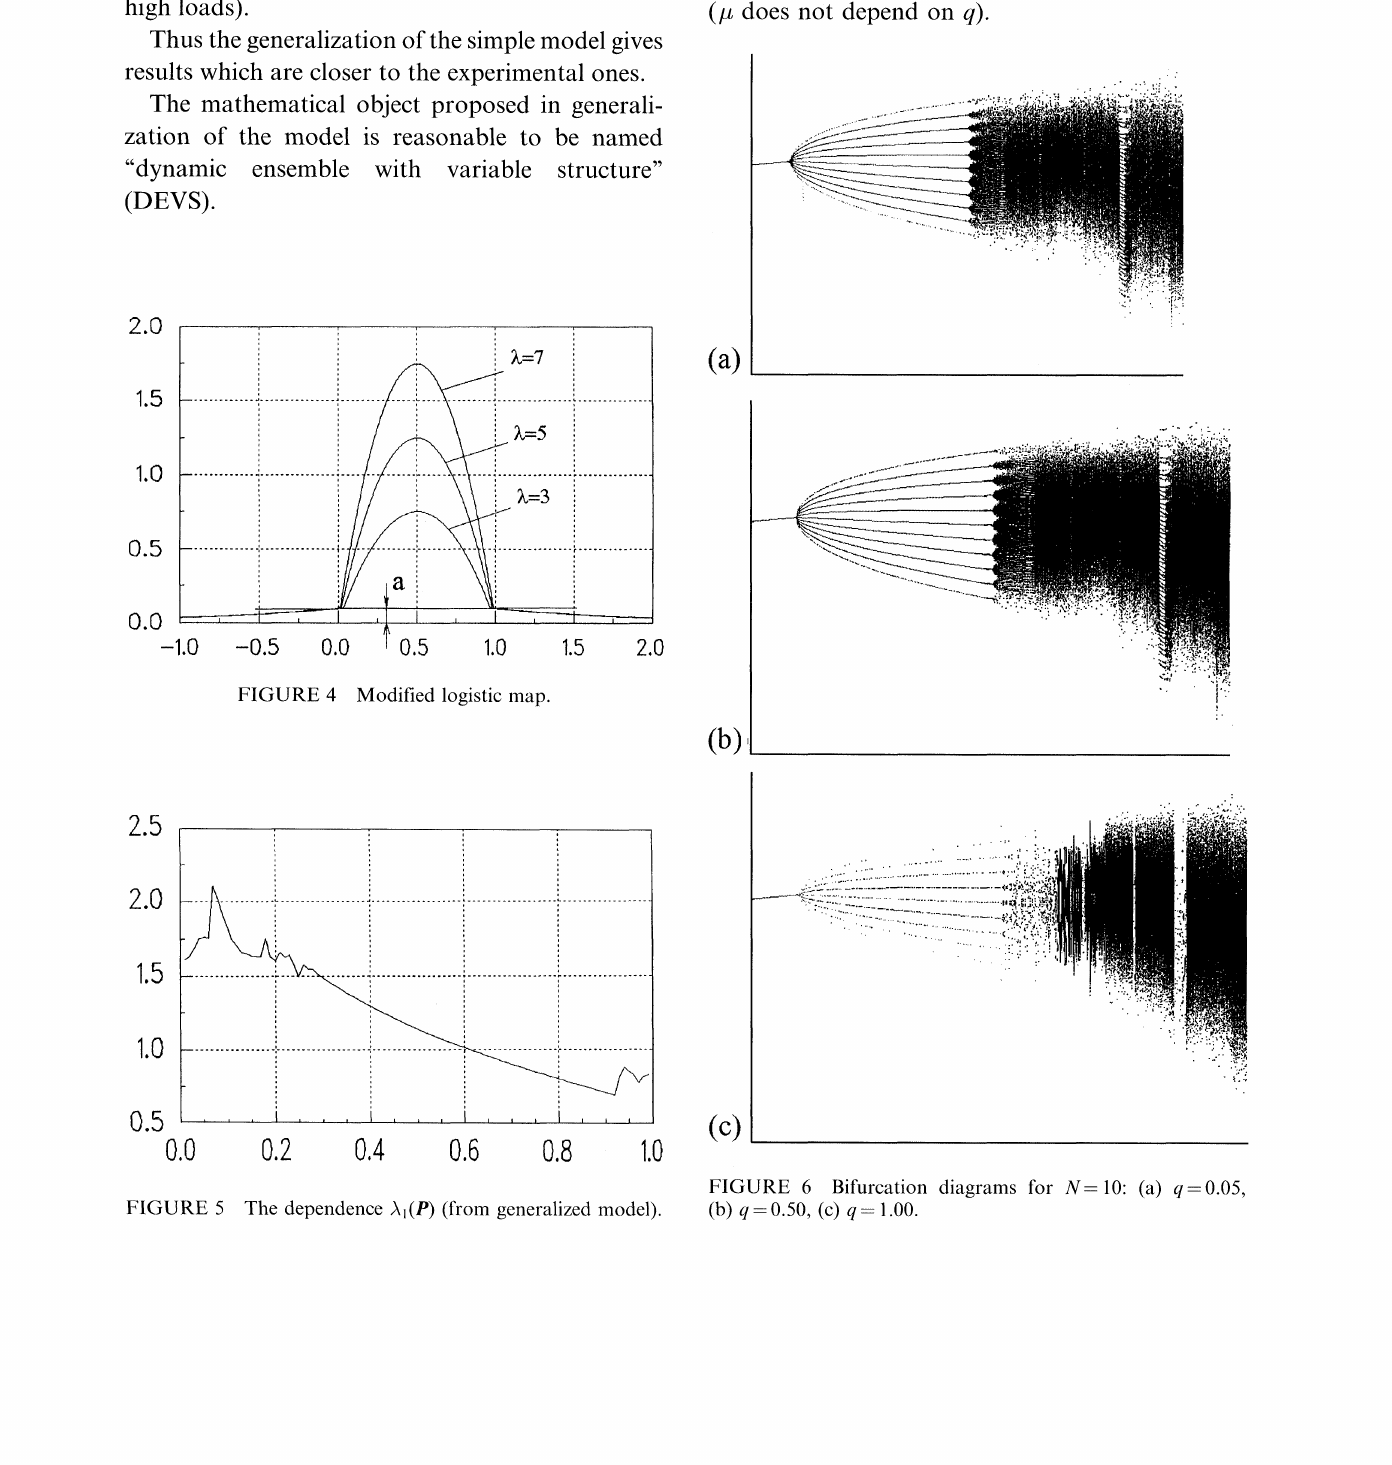
FIGURE 6 Bifurcation diagrams for N= 10: (a) q=0.05, (b) q 0.50, (c) q